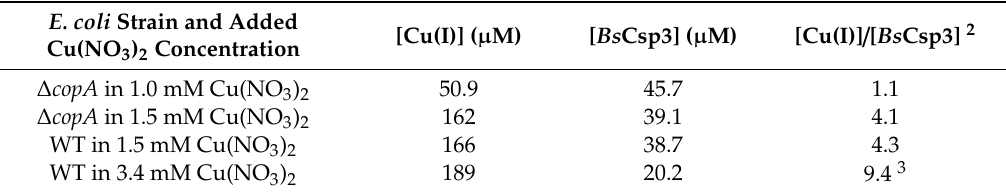
Figure 7. Gel-filtration chromatography of Bs Csp3-containing anion-exchange fractions. Plots of Cu(I) concentration against elution volume when the anion-exchange fractions that eluted at 37 and 39 mL respectively, from cell-free extracts of ∆ copA E. coli overexpressing Bs Csp3 grown in 1.0 ( A ) and 1.5 ( B ) mM Cu(NO 3 ) 2 were analyzed by gel-filtration chromatography. Also shown are the gel-filtration analyses of the anion-exchange fractions eluting at 39 and 43 mL when overexpressing Bs Csp3 in WT E. coli grown in 1.5 ( C ) and 3.4 ( D ) mM Cu(NO 3 ) 2 , respectively. Insets show SDS-PAGE gels confirming the main protein component in these fractions is Bs Csp3 (indicated by an arrow), and open squares identify which fractions were analyzed. Table 1. The number of Cu(I) equivalents bound by Bs Csp3 from the two E. coli strains grown at different Cu concentrations 1 .